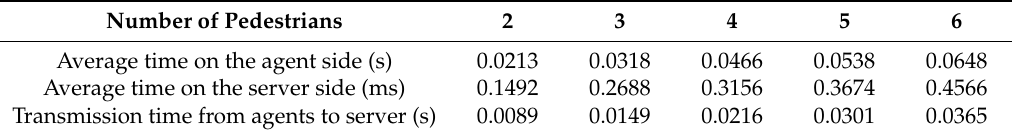
Table 3. The average processing time on the agent side, the recognition time on the server side, and the transmission time from agents to the server with different number of